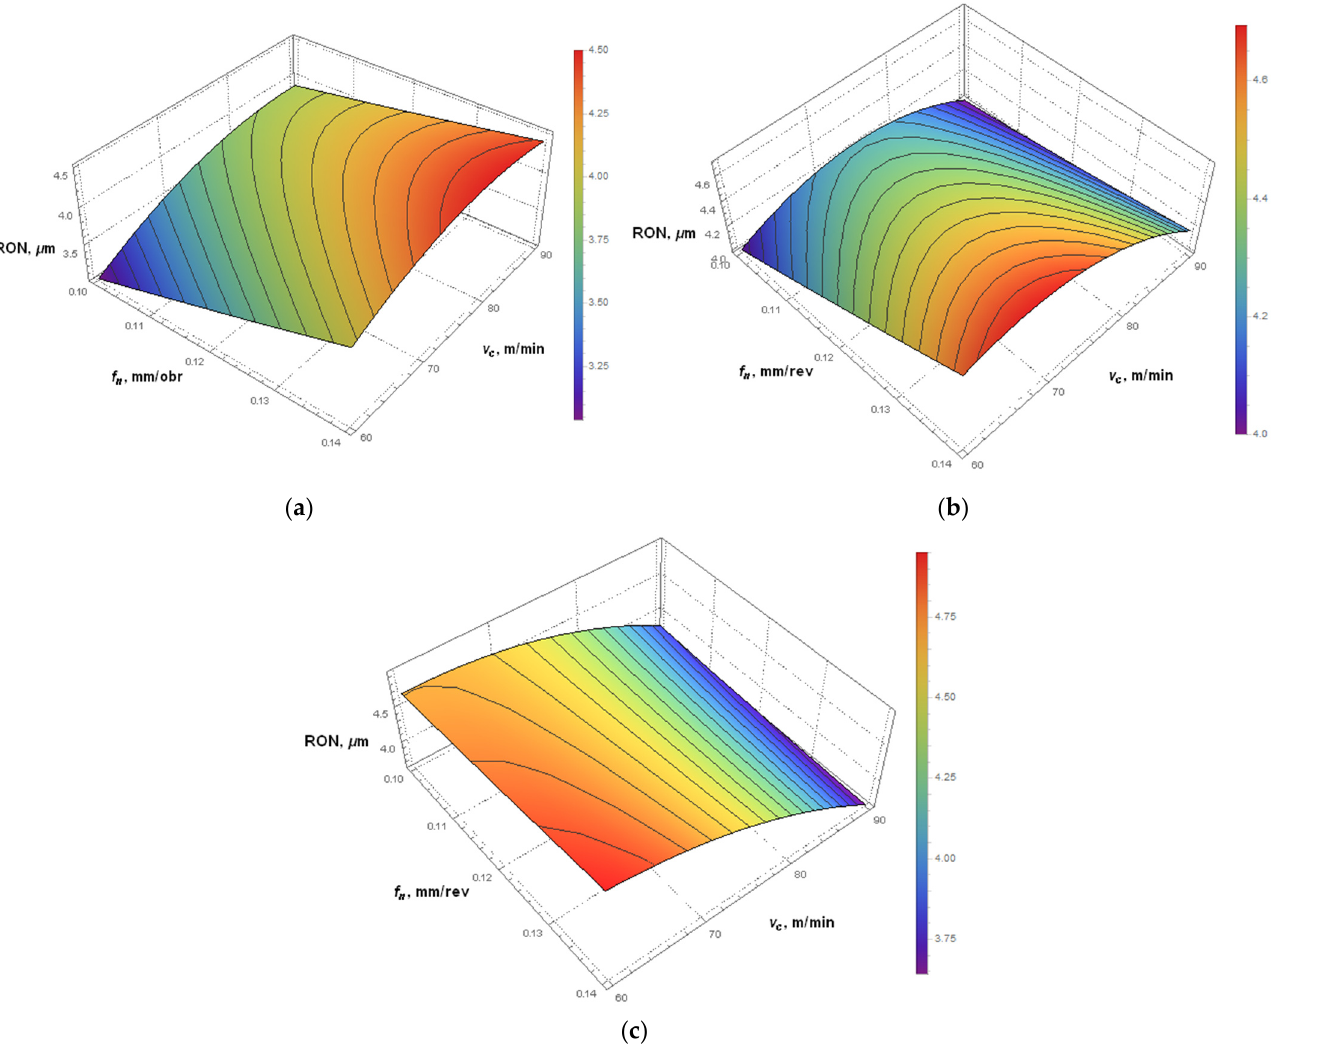
Figure 6. Simulations of the hole roundness error for: ( a ) KIN I, ( b ) KIN II; ( c ) KIN III.